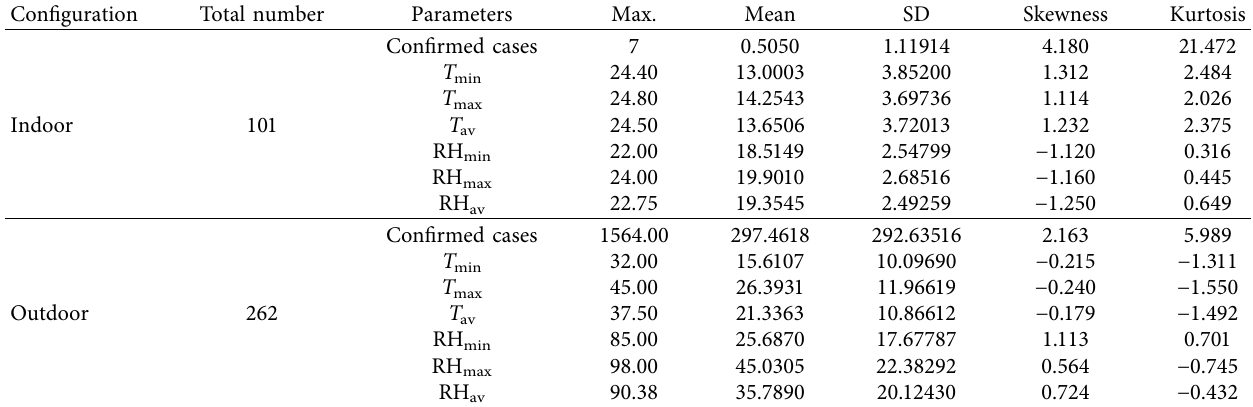
Table 1: The descriptive analysis of confirmed COVID-19 cases and environmental data.